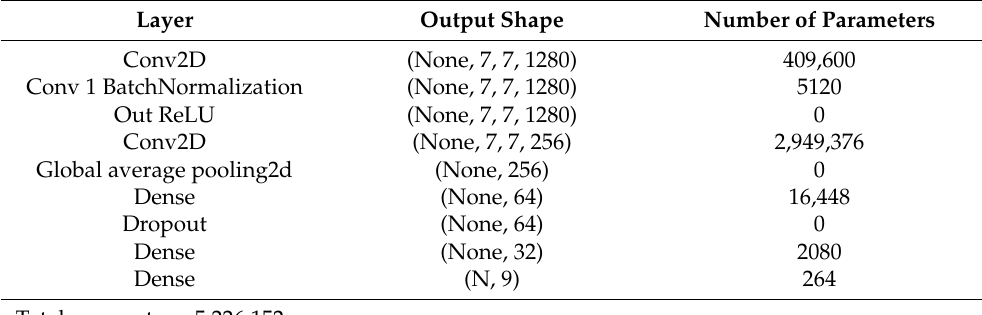
Table 3. Summary of the custom layers added to the pre-trained MobileNet-v2